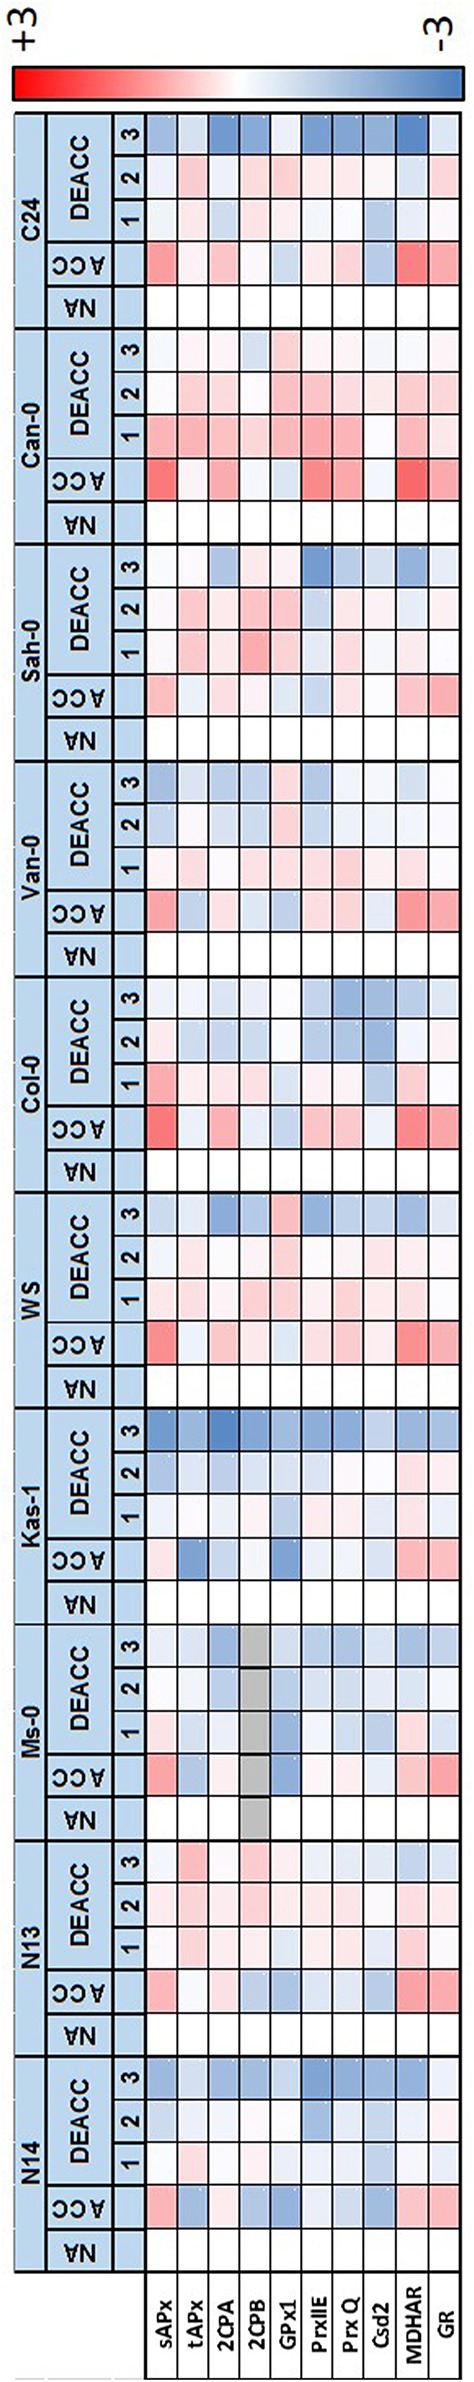
Heat-map depicting the log2-fold change in relative gene expression (Supplementary Figure 1) between non-acclimated (NA), cold-acclimated plants (ACC) and 1–3 day long deacclimated plants (DEACC1–DEACC3) on the scale from −3 (blue) to 3 (red). Data below detection level are labeled in gray. Accessions are ordered from the lowest LT50 after cold acclimation on the left to the highest on the right.